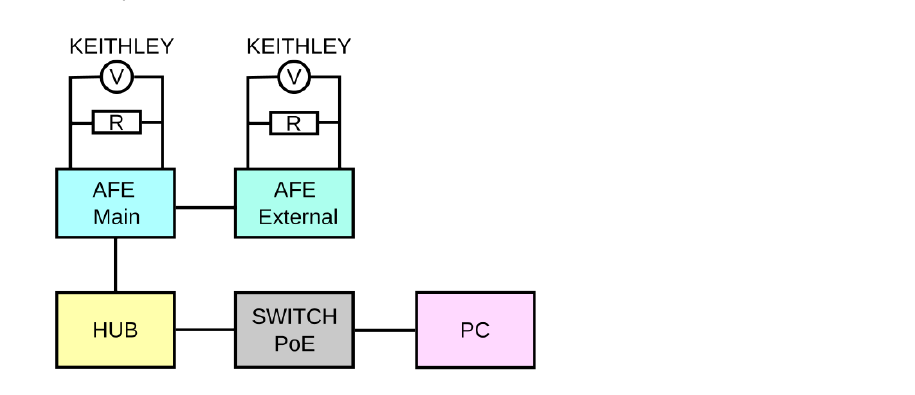
Figure 10. Visualisation of the measuring station using the complete MCORD detector slab ( left ), and when the AFE plates are separated from the detector slab to be used with an external precision Keithley meter ( right ).